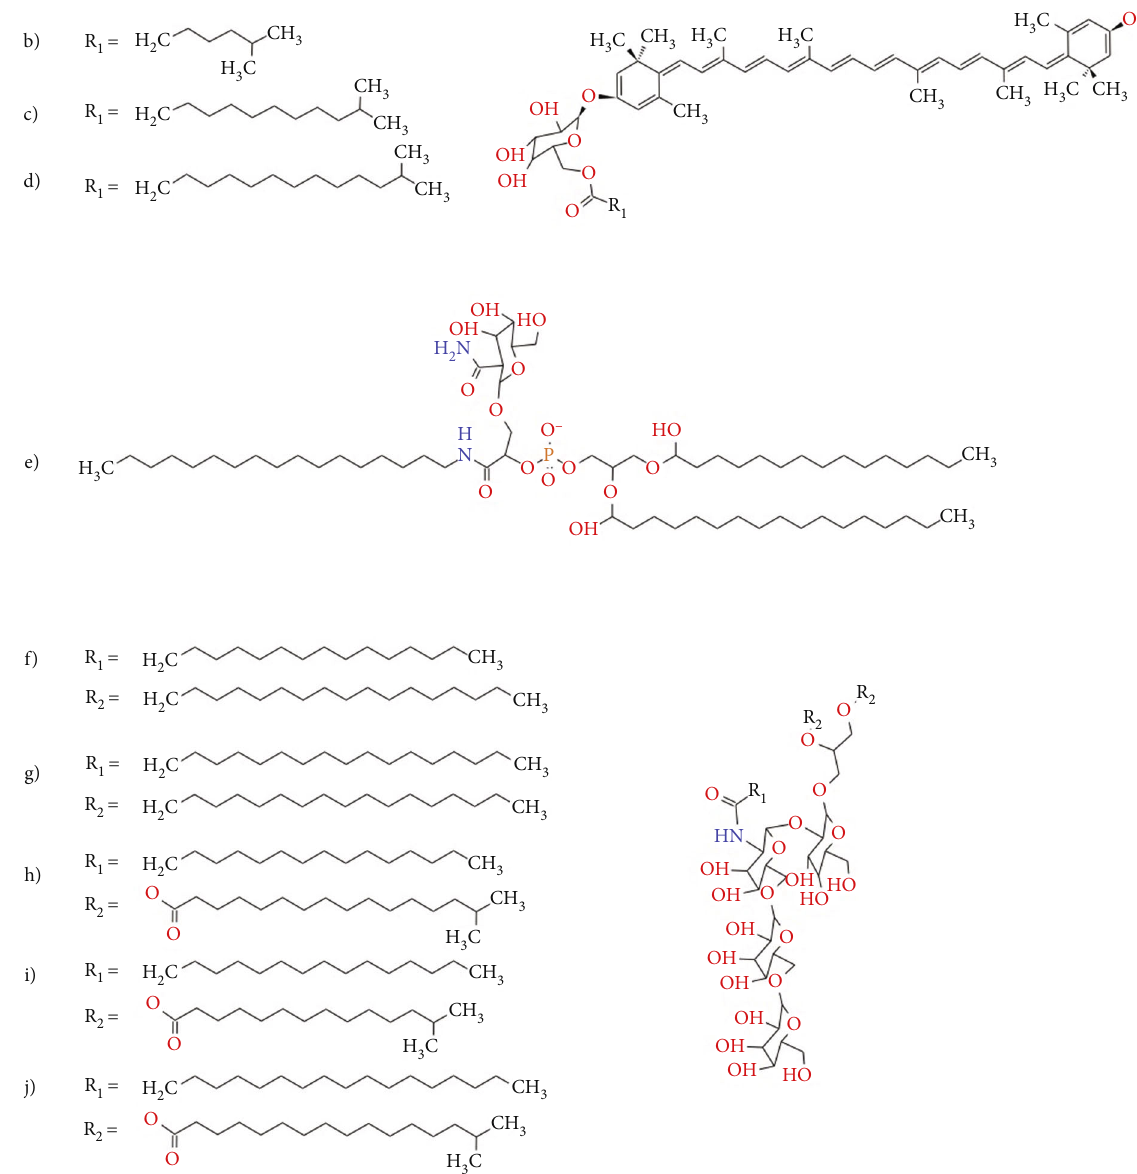
Figure 3: Chemical structure of the ligand molecules in the experimental group used for molecular docking: (a) Helix-Y 12 , (b) Tzeax, (c) Tzeax-13, (d) Tzeax-15, (e) gpl01, (f) gl01, (g) gl02, (h) gl03, (i) gl04, and (j)